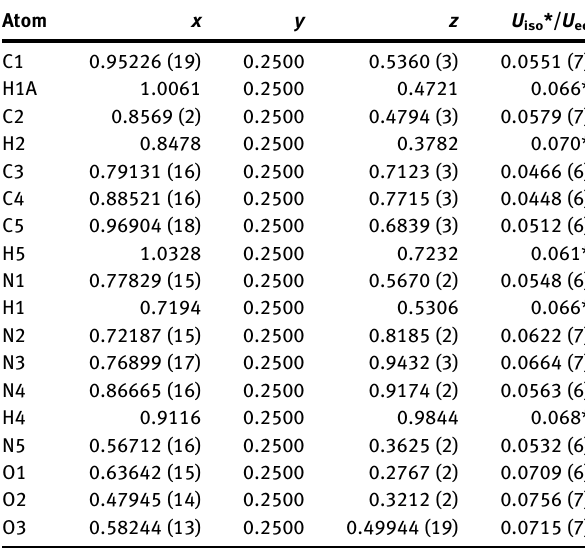
Table  : Fractional atomic coordinates and isotropic or equivalent isotropic displacement parameters (Å 